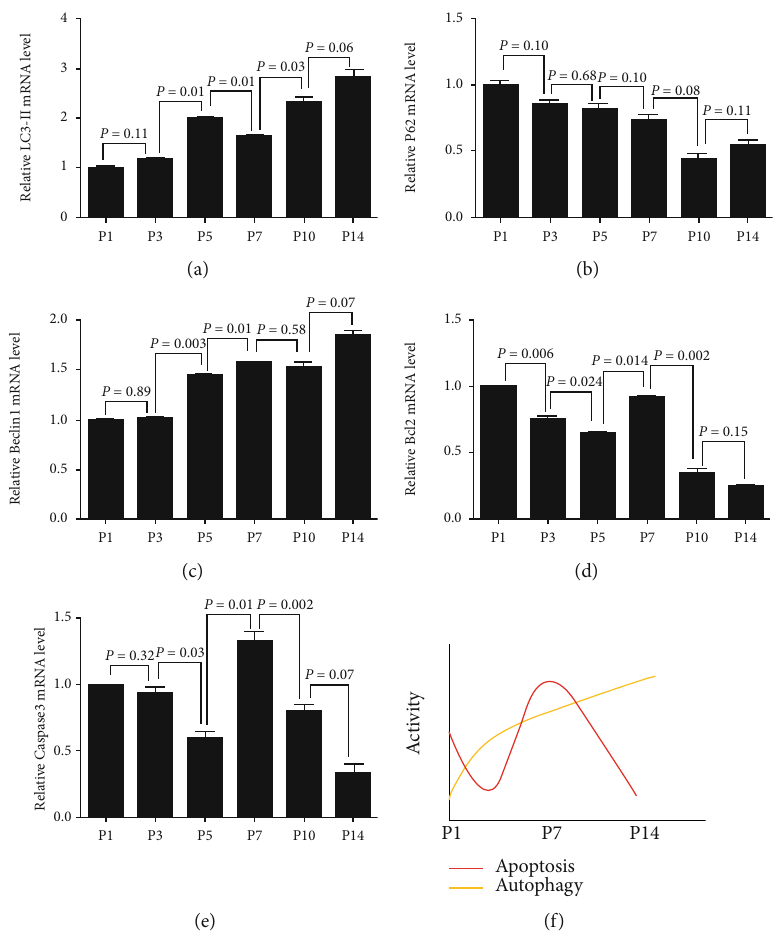
Figure 4: Real-time PCR quantitative analysis of autophagy machinery genes and apoptosis-associated genes in SGNs during the postnatal development. (a – c) The transcription expression of LC3-II , P62 , and Beclin1 showed that the autophagy activity was upregulated with the development of SGNs. (d, e) The transcription expression of Bcl2 and Caspase3 showed maximal apoptotic activity at P7. (f) The overall expression trend of apoptosis and autophagy. Data from triplicate samples were normalized to those at P1. Signi fi cant di ff erences were evaluated using repeated measures